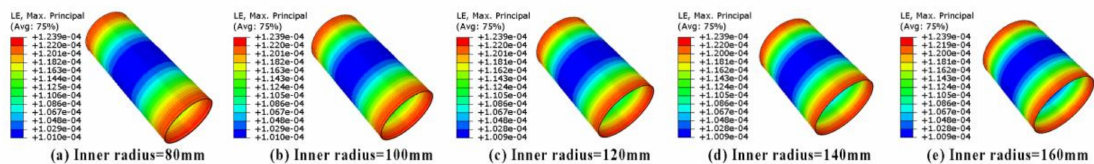
Figure 7. Influence of the inner radius on stress of variable-stiffness composite cylinders.